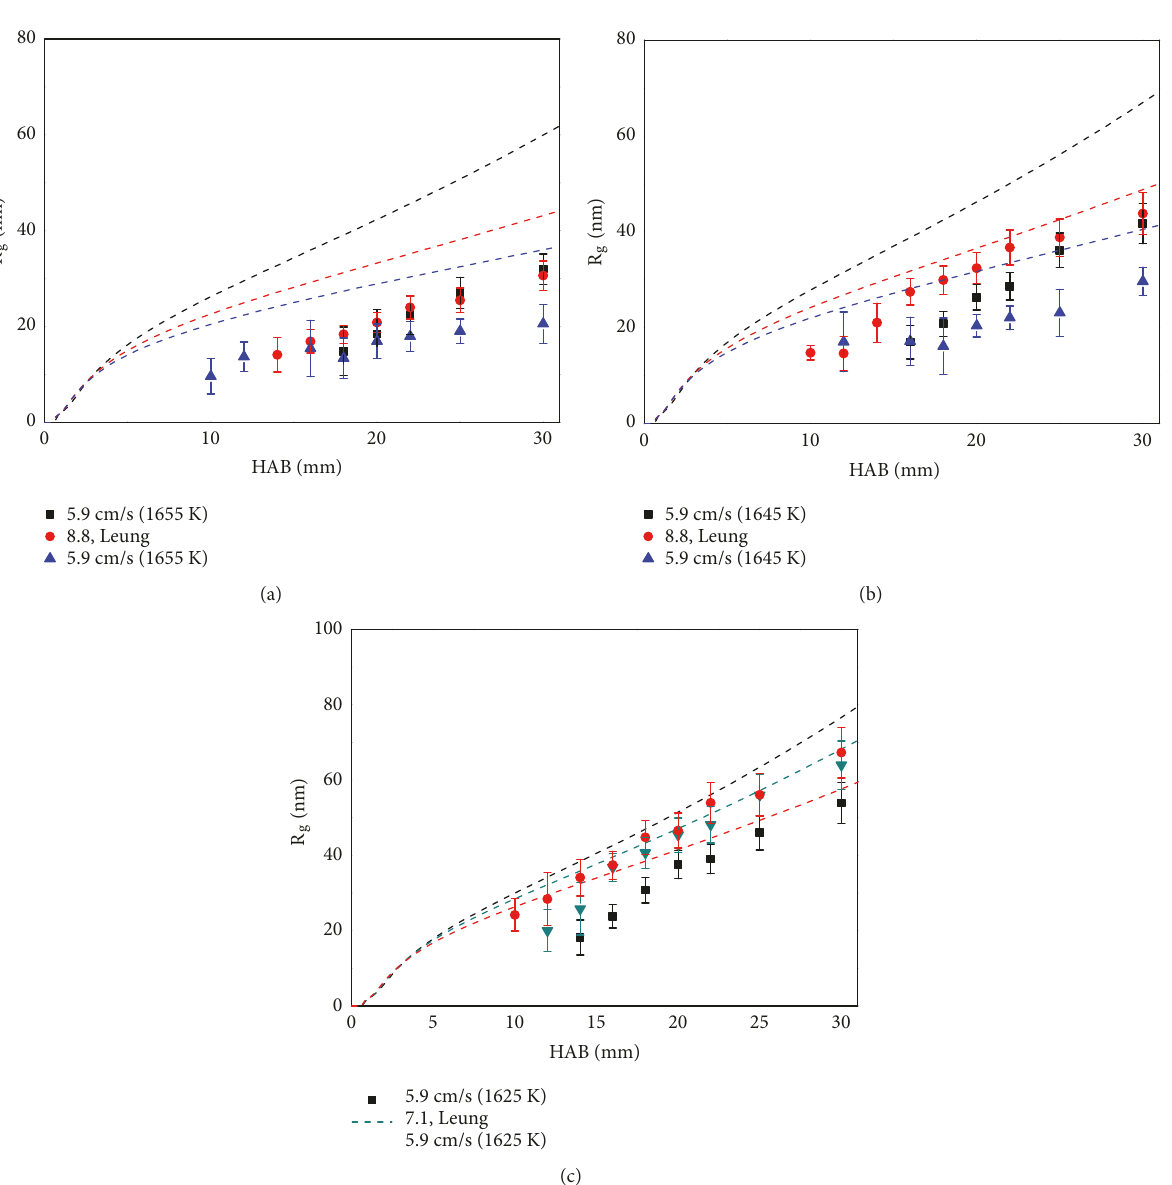
Figure8:Measured(symbols)andcomputed(Leungetal.[19],dashedlines)axialprofilesof 𝑅 𝑔 forthreedifferentexitvelocitiesatequivalence ratios (a) 𝜙 = 2.1, (b) 𝜙 = 2.2, and (c) 𝜙 =